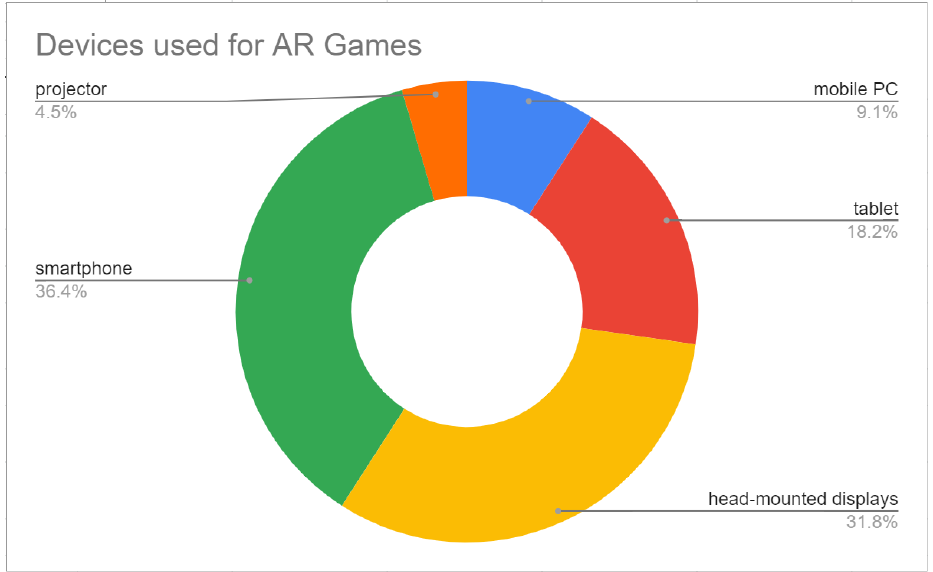
Figure 3. Summary of devices used for the AR studies analysed.